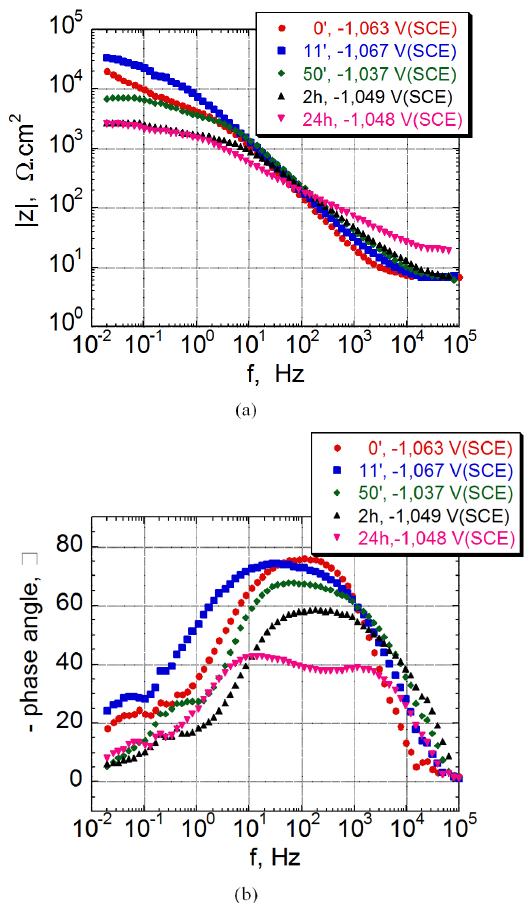
Figure 4. (a) Bode magnitude and (b) phase angle plots as a function of immersion time in aerated 0.3 mol.L –1 Na for nitro-cobalt electrogalvanised steel coating – sample protected with treatment B.